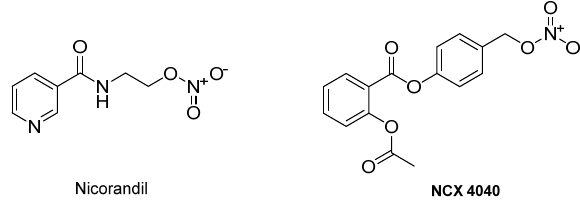
Figure 1. Nicorandil and the derivative NCX 4040.